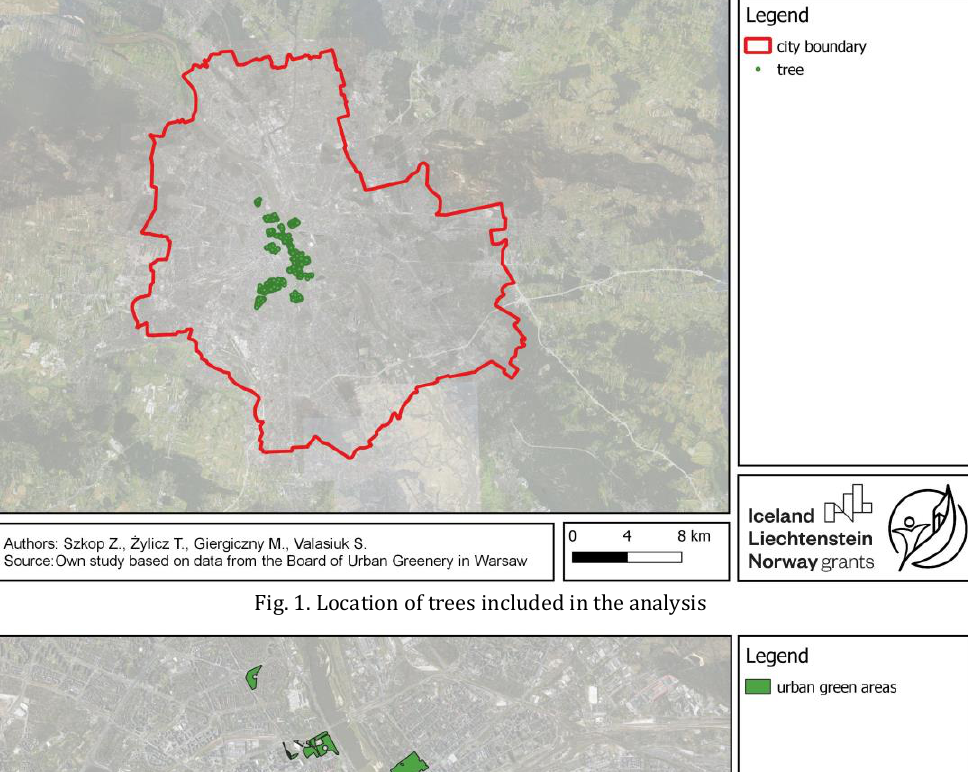
Fig. 1. Location of trees included in the analysis